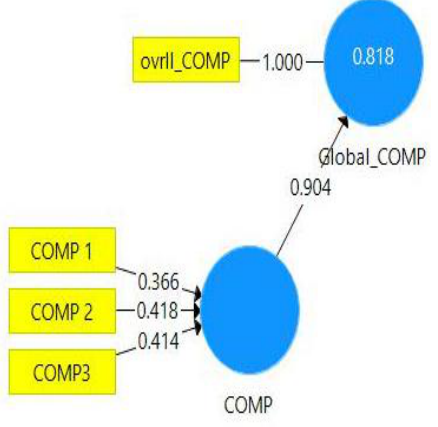
Figure 3. Redundancy analysis (Compatibility).